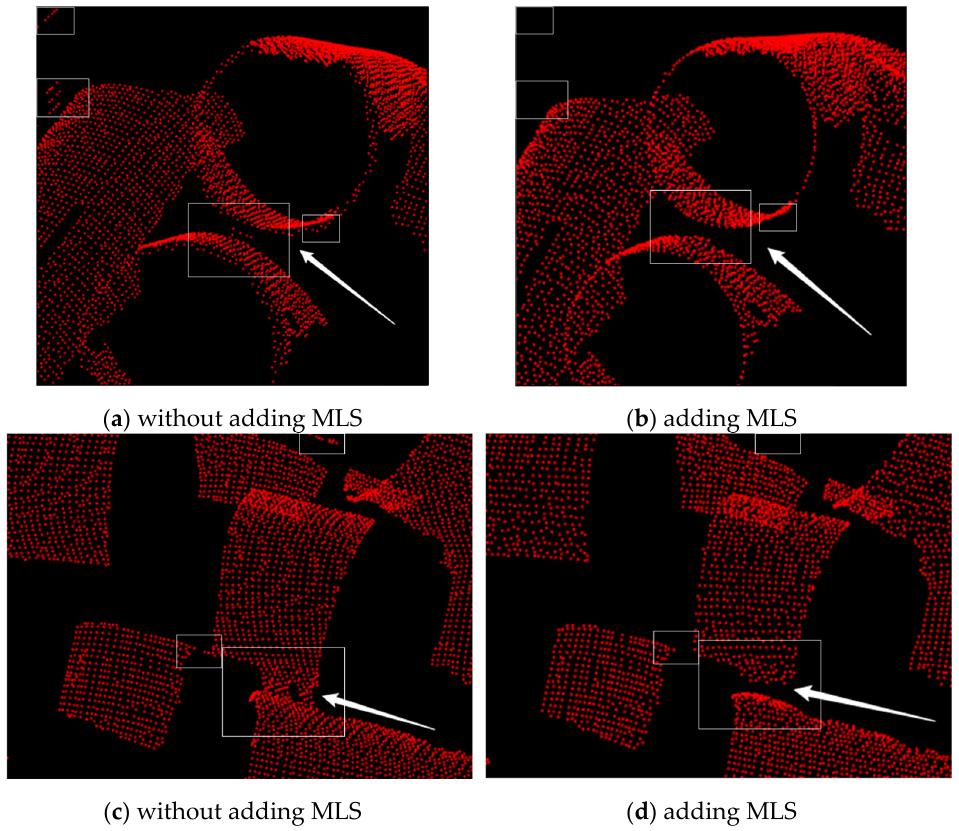
Figure 7. The results of the MLS surface fitting filter. ( a , b ) are the point clouds before and after adding the MLS surface fitting filter in the same scene, respectively. ( c , d ) are the point clouds in the other